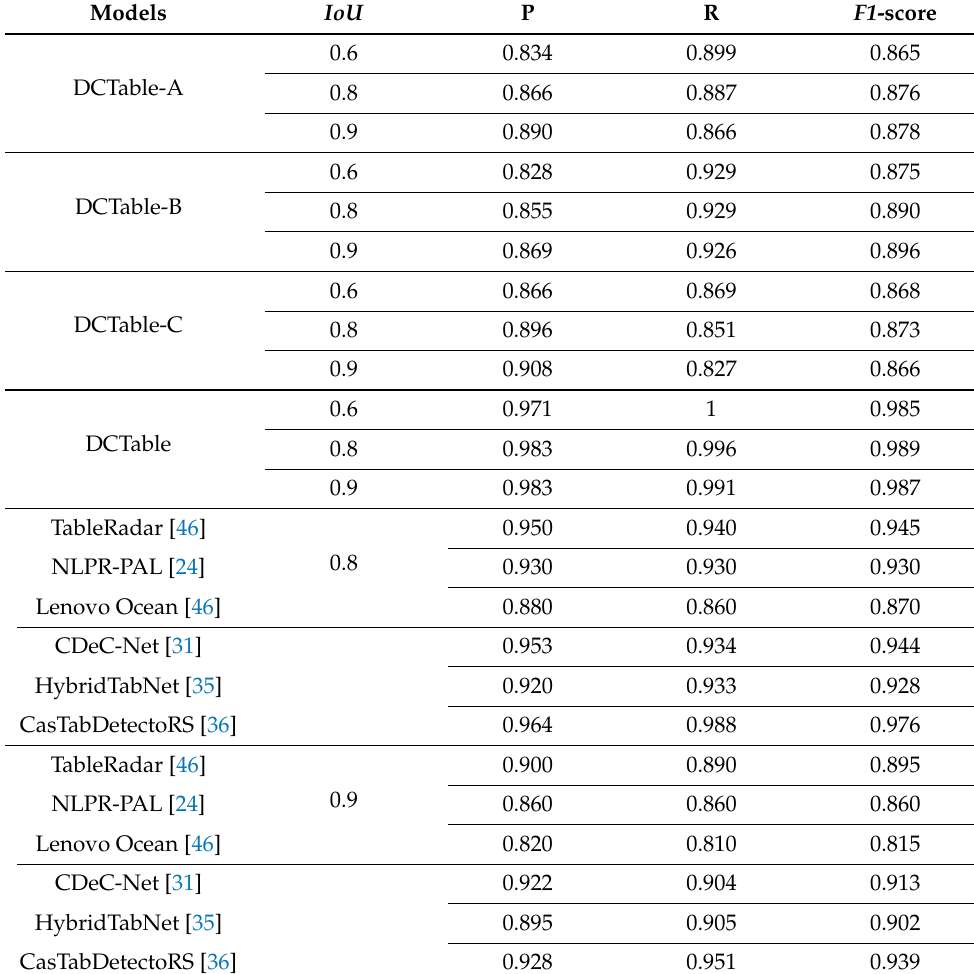
Table 2. Evaluation on ICDAR